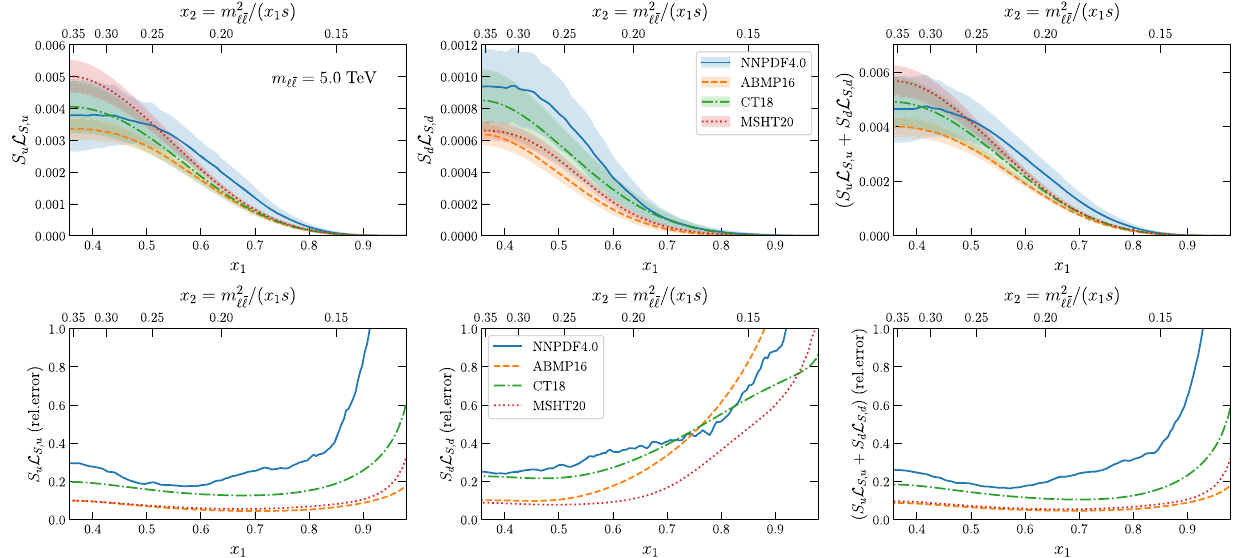
display L S , u , L S , d , and their weighted sum that enters the coefficient g S , q in Eq. (2.18). The bottom panels display the relative 68% CL PDF